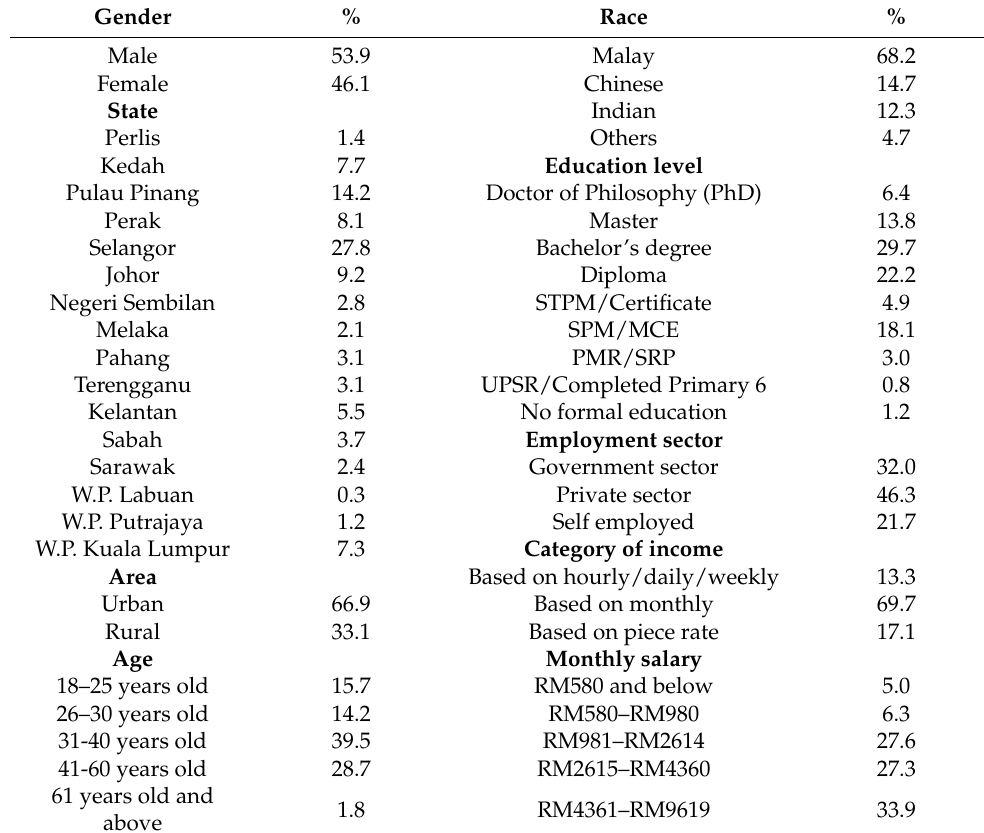
Table 1. Respondents’